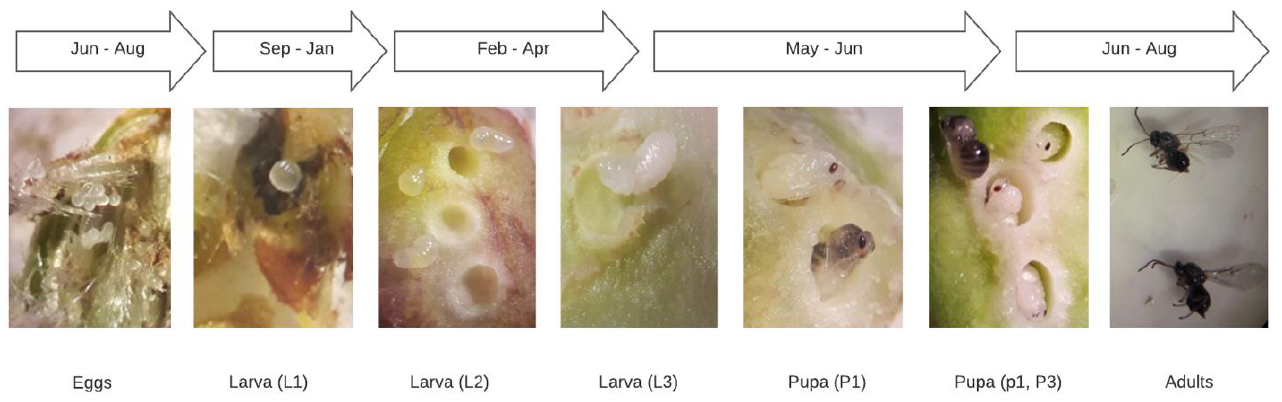
Figure 3. Developmental stages of D. kuriphilus .